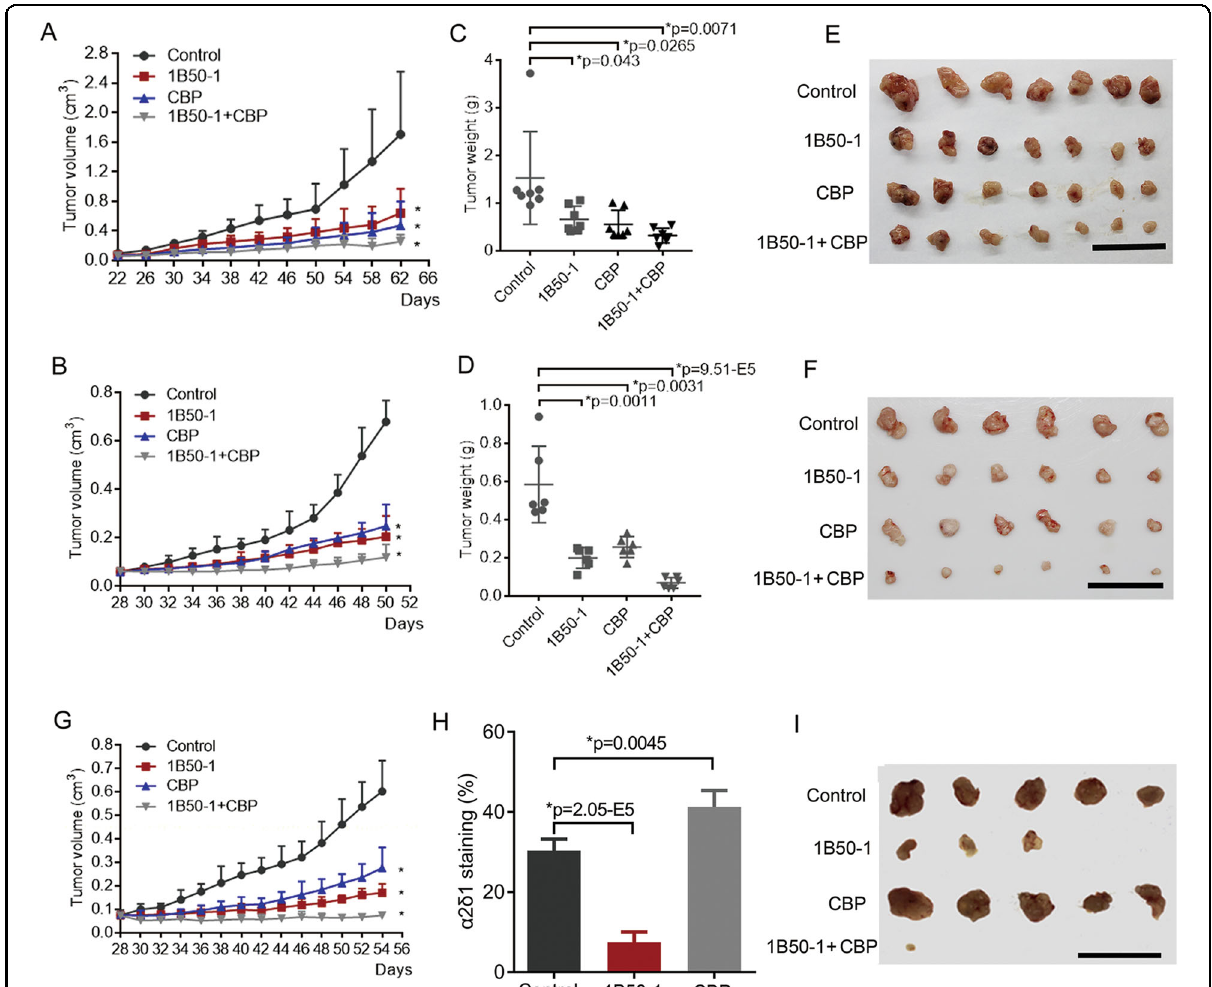
Fig. 8 The therapeutic effects of anti- α 2 δ 1 mAb1B50-1 on established NSCLC engraftments in NOD/SCID mice. A , B Growth curves of A549 ( A ) and H520 ( B ) engraftments treated with 800 μ g/mouse 1B50-1, 1.5 mg/kg carboplatin (CBP), or the combination of both, every other day after the tumors were visible. C , D The histograms showing the average weight of the dissected tumors of A549 ( C ) and H520 ( D ) engraftments treated with indicated regimens. E , F Photographs of the dissected tumors of A549 ( E ) and H520 ( F ) engraftments received the indicated treatments. ( G ) Growth curves of one NSCLC PDX tumors i.p. injected with 1B50-1, CBP, or the combination of both. H Histogram demonstrates the percentage of α 2 δ 1 + cells in the residual tumors of A549 xenografts received the indicated treatment as detected by fl ow cytometry. I Dissected tumors showing the tumor-initiating ability of the A549 engraftment residues after each drug treatment, which was assayed by re-transplanting 10 4 cells per site with Matrigel into NOD/SCID mice. Scale bars, 5 cm. All error bars indicate SD. * p ≤ 0.05, compared with vehicle control group. Student ’ s t